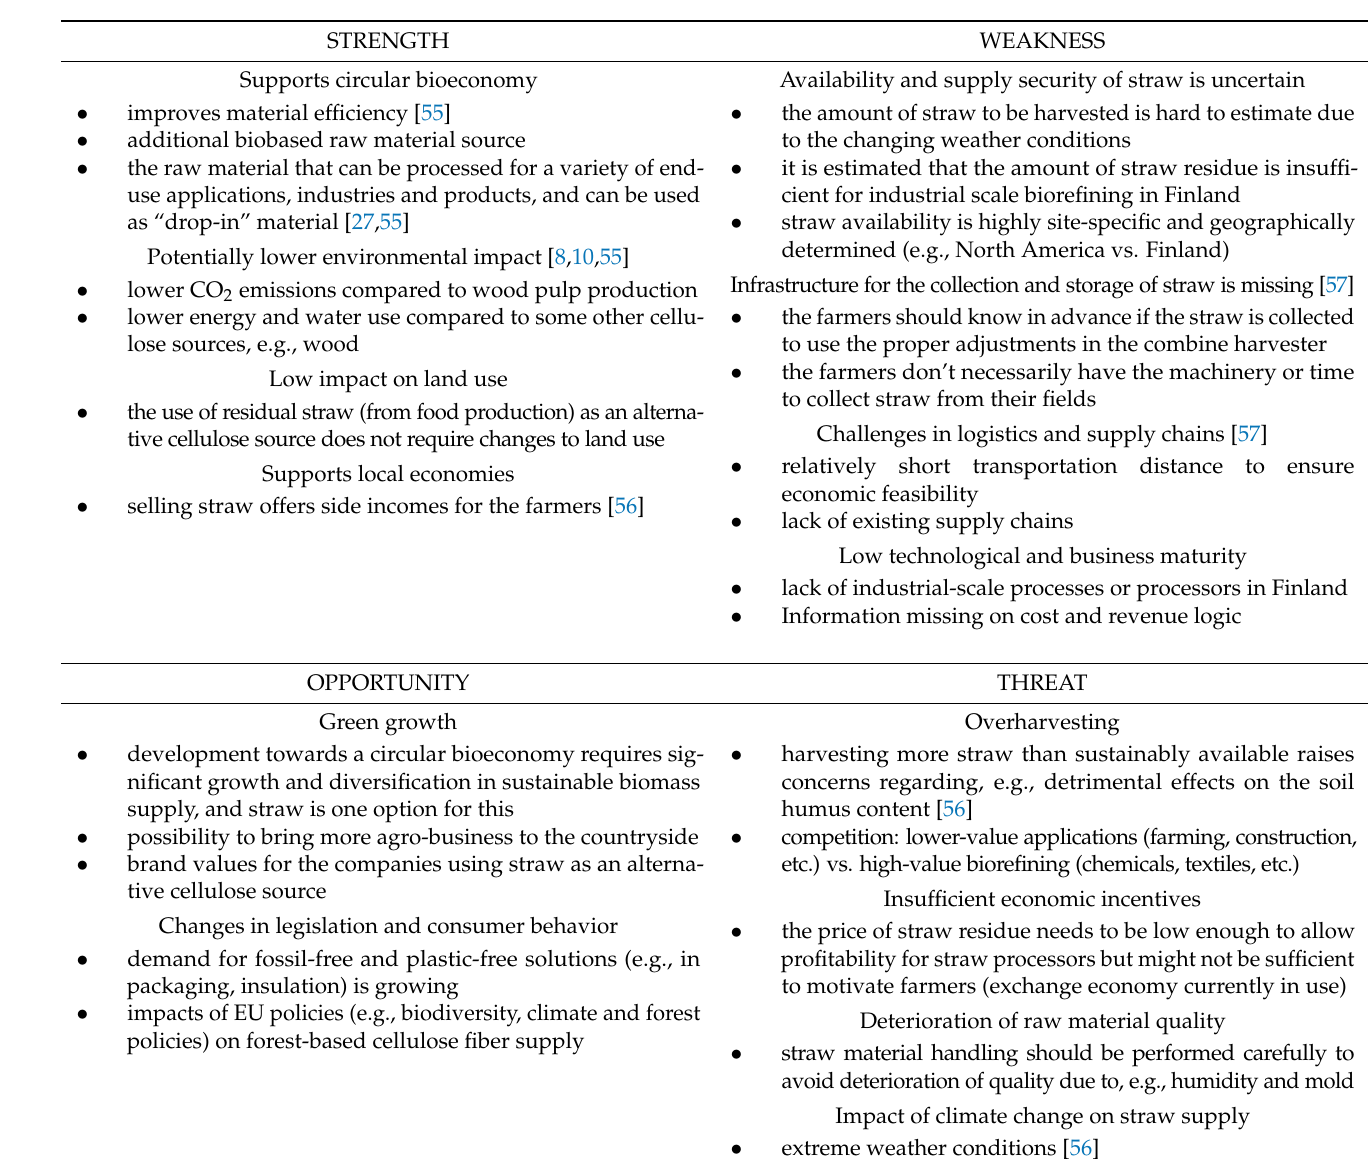
Table A1. An overview of potential strengths, weaknesses, opportunities and threats related to residual straw use as a raw material (based on the literature, expert interviews, and the authors’